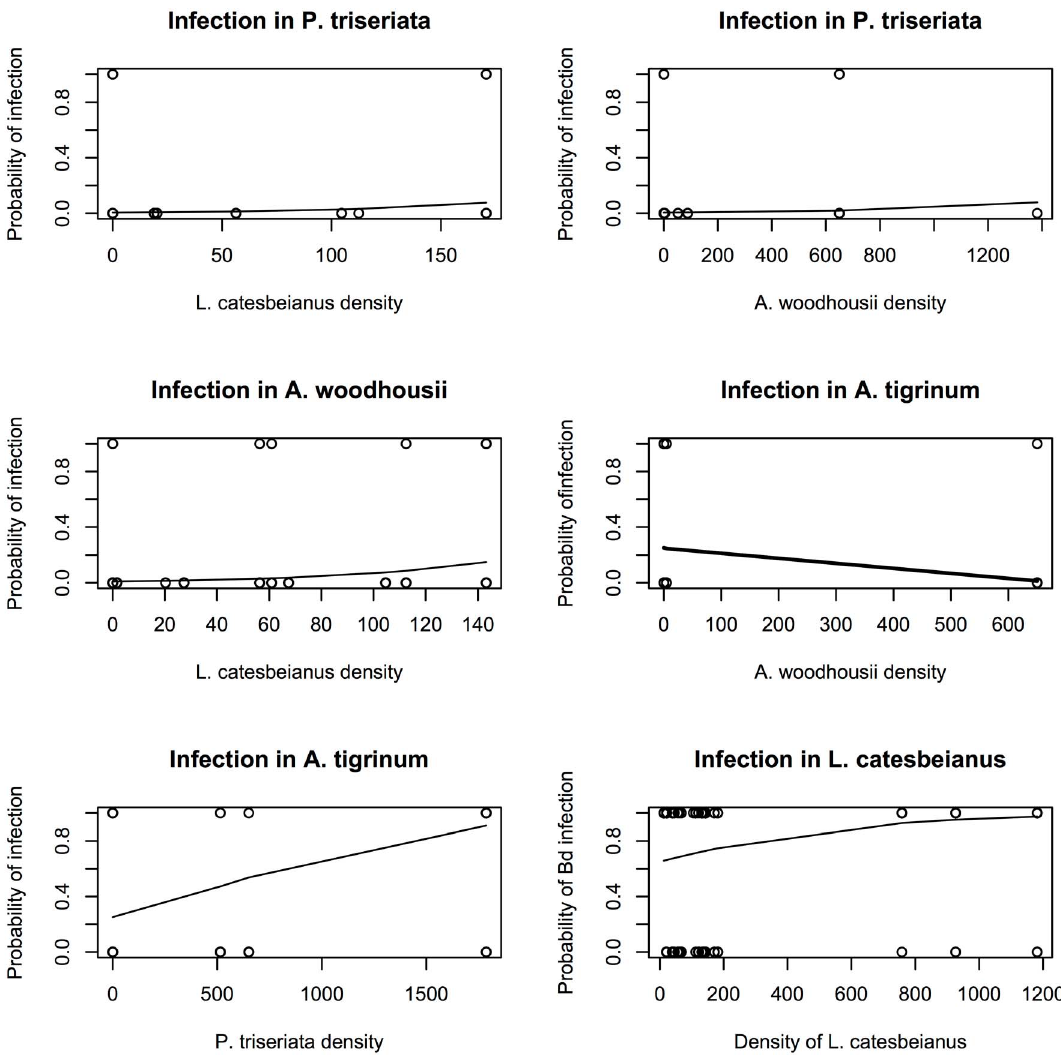
Figure 2. Relationship between density of host species and the probability of Bd infection in individuals. The density of L. catesbeianus at a wetland was a statistically significant predictor of infection in both A. woodhousii (p=0.0065) and P. triseriata (p=0.024), as obtained from generalized linear mixed effects models predicting the probability of Bd infection in individual species encountered in the field survey. The density of A. tigrinum (not shown), A. woodhousii , and P. triseriata were all statistically significant predictors of infection in A. tigrinum (p=0.034, 0.006, 1.5e-5, respectively). The density of L. catesbeianus at a wetland was a nearly statistically significant predictor of infection in that species (p=0.093), though the density of no other amphibian species was statistically significantly related to infection in L. catesbeianus (p . 0.3 for all other